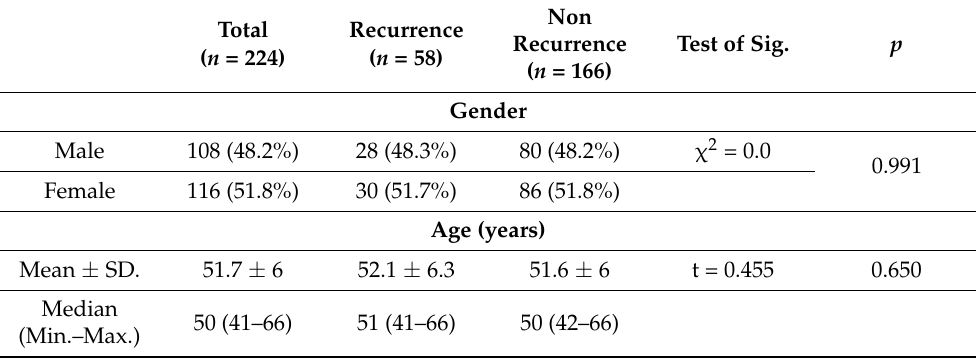
Table 1. Demographic data of the two studied groups of patients.